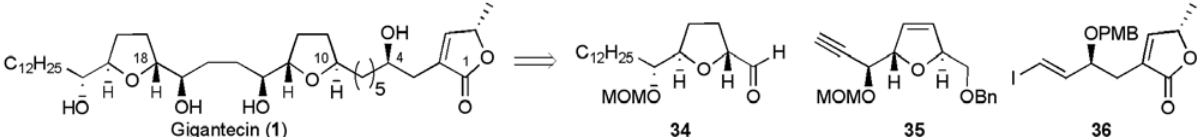
Figure 8. Crimmims’ approach to gigantecin ( 1